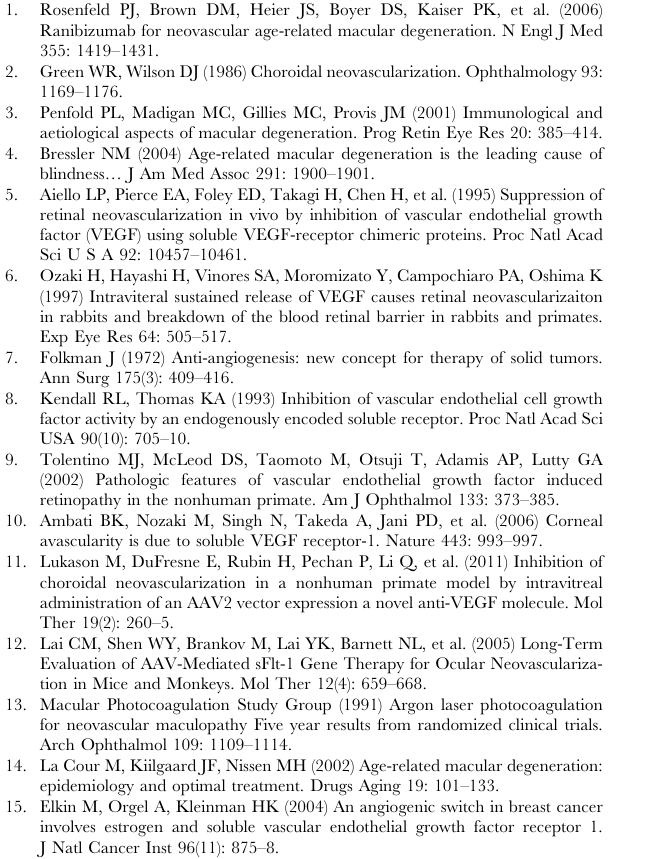
Figure S2 Intra-tumoral injection of VEGFR1_MOe13 target- ing human FLT-1 does not induce xenograft tumor regression. MB-MDA-231 breast cancer cells were grown as xenografts in female nude mice for 2 weeks prior to beginning intra-tumoral injection treatment with either a standard morpholino or VEGFR1_MOe13 morpholino targeting the human FLT-1 transcript. Change in tumor volume was assessed following a 4 week treatment course. p=